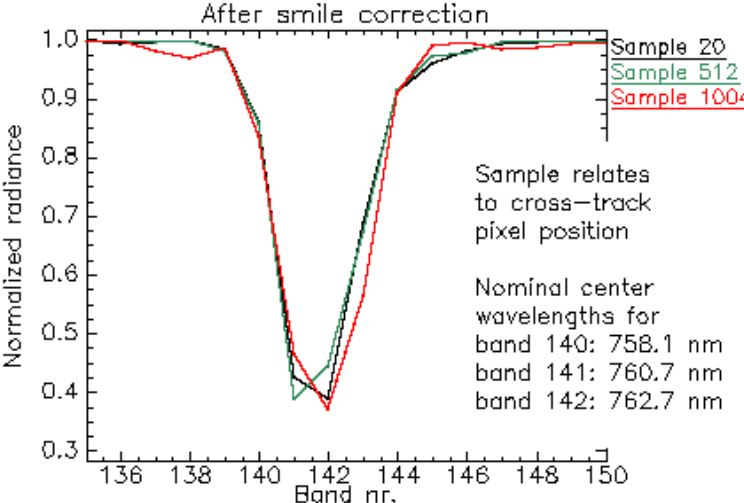
Figure 20. Example of the cross-track derivation of the Oxygen A absorption feature after smile